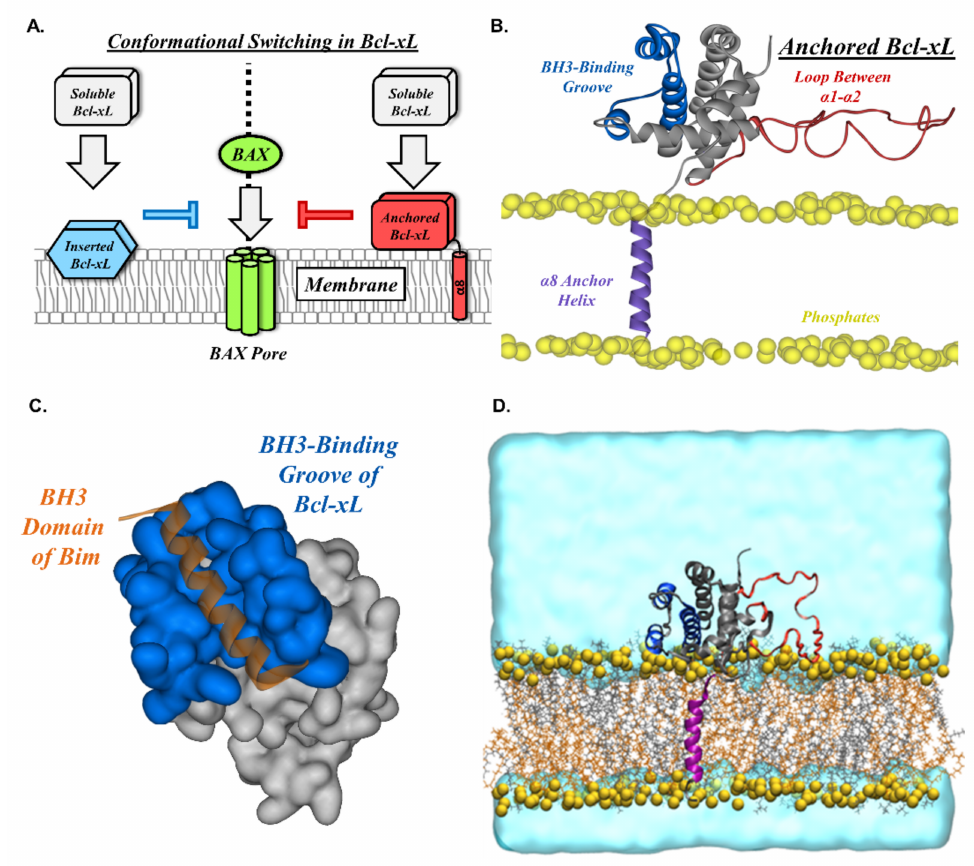
Figure 1. Membrane associated Bcl-xL. ( A ) According to the “embedded together” model, the interac- tions between the anti-apoptotic protein Bcl-xL and its pro-apoptotic targets (e.g., pore-former BAX) require their transition to the mitochondrial outer membrane [9]. Two different membrane-integrated Bcl-xL conformations have been identified: membrane-inserted and membrane-anchored Bcl-xL. The former is characterized by extensive refolding [15,16], while the latter retains the fold of the soluble state (aside from the released α 8 anchor helix) [12–14]. Here, we focus on the membrane-anchored conformation of Bcl-xL and the influence of cardiolipin and protonation on its conformational dy- namics. ( B ) The initial configuration of membrane-anchored Bcl-xL used in the all-atom molecular dynamics simulations. The protein is shown in secondary structure representation. The soluble head region (helices α 1 through α 7) is shown in grey with its BH3-binding groove highlighted in blue. The loop connecting α 1 and α 2 is shown in red and the α 8 anchoring helix is shown in purple in a transmembrane configuration. The lipid phosphate phosphorus atoms are shown as yellow spheres. The rest of the simulation system has been removed for clarity. ( C ) A surface representation of the BH3-binding groove of Bcl-xL (blue) bound to the BH3 domain of Bim (orange), PDB ID: 3FDL. ( D ) A cut-away representation of the complete simulation system. The protein and lipid phosphate phosphorus atoms are rendered as in ( B ), the rest of the lipid molecules are shown in licorice representation (POPC, grey; TOCL, orange), and water molecules are rendered as slabs in